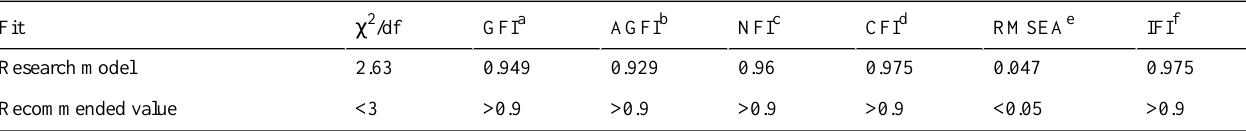
Table 6. Fit indexes of the research